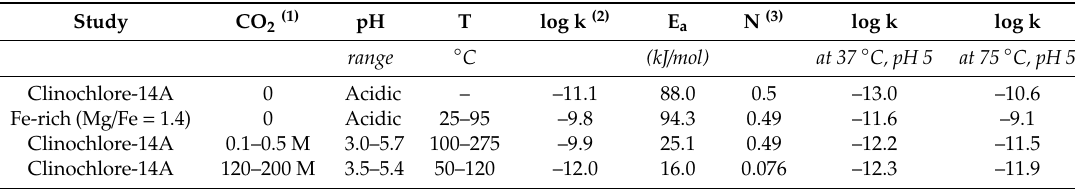
Table 3. Kinetic data for